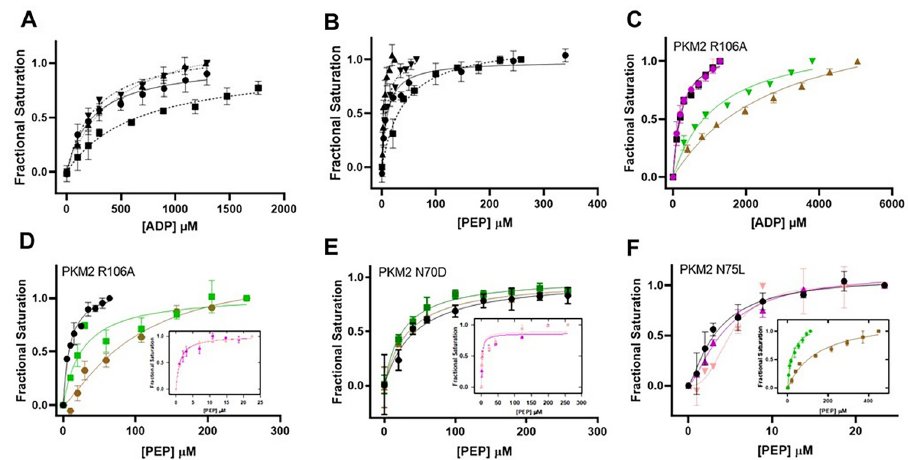
Fig 2. Determination of substrate binding affinity of PKM2 variants. (A) Binding of ADP and (B) PEP to wtPKM2 (- ● -), PKM2 N70D (— ■ —), PKM2 N75L ( ⸱⸱▲⸱⸱ ), and PKM2 R106A ( ⸱⸱ − ▼⸱⸱ − ).The ADP and PEP binding affinity of PKM2 N70D is weaker than that of wtPKM2 and other variants. The PEP binding affinity of PKM2 R106A is similar to wtPKM2, and that of PKM2 N75L is slightly tighter than wtPKM2. (C) ADP binding studies of PKM2 R106A in the absence (black) and presence of Asn (magenta), Asp (salmon), Val (green), and Cys (brown). The ADP binding affinity of the R106A variant decreases in the presence of Val and Cys, while Asn and Asp do not affect it. (D-F) PEP binding affinities of (D) PKM2 R106A (E) PKM2 N70D (F) PKM2 N75L in the absence and presence of the AAs (color scheme for the AAs is identical to (C)). The PEP binding affinity of PKM2 R106A increased in the presence of Asn/ Asp (inset in D) and decreased upon incubation with Val/Cys. The PEP binding affinity of PKM2 N70D increased in the presence of Asn and Asp (inset in E), while Val/Cys did not affect the K d . For PKM2 N75L, Val and Cys decrease its PEP binding affinity (inset in F), while Asn/Asp have no effect. The concentration of each enzyme used in all experiments were 1.6 μ M and all the AA concentrations were constant at 1 mM. The K d values are listed in S2